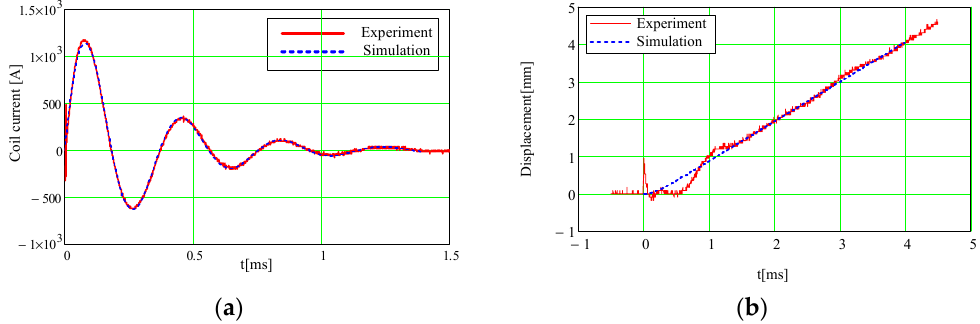
Figure 8. Comparison of results obtained from the experiment and simulation research for parameters from Table 1 at C = 100 μ F ( a ) coil current ( b ) disc displacement.